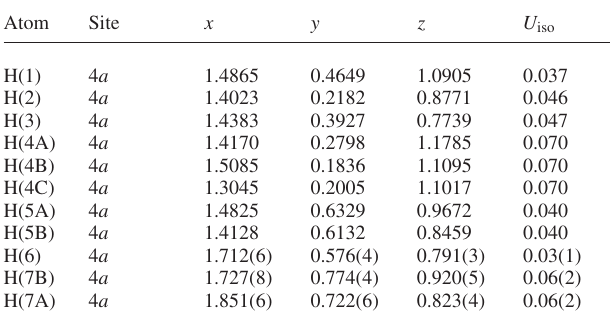
Table 2. Atomic coordinates and displacement parameters (in Å 2 )